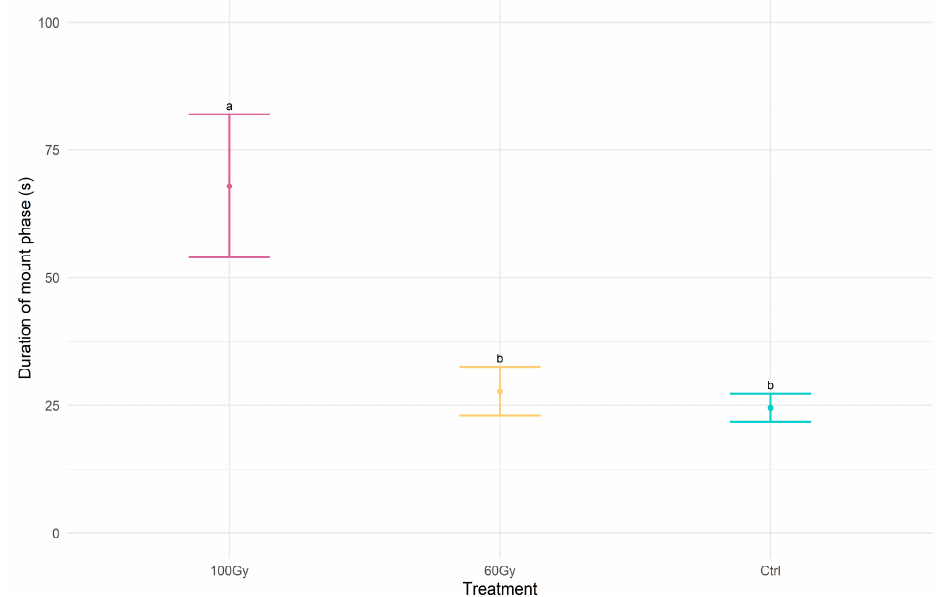
Figure 6. Dot plot with error bars of the time interval counting from the beginning of the mount phase to the beginning of mating. The treatments indicated with different letters show significant differences (Kruskal–Wallis test at p < 0.05). The dot represents the mean of delta time, and the error bar represents the standard error of the mean.